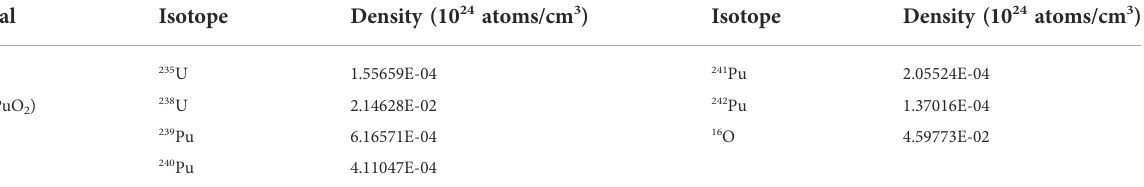
TABLE 3 Material compositions.